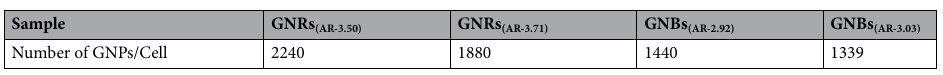
Table 1. Uptake of GNRs and GNBs of different sizes by a single HepG2 cell.